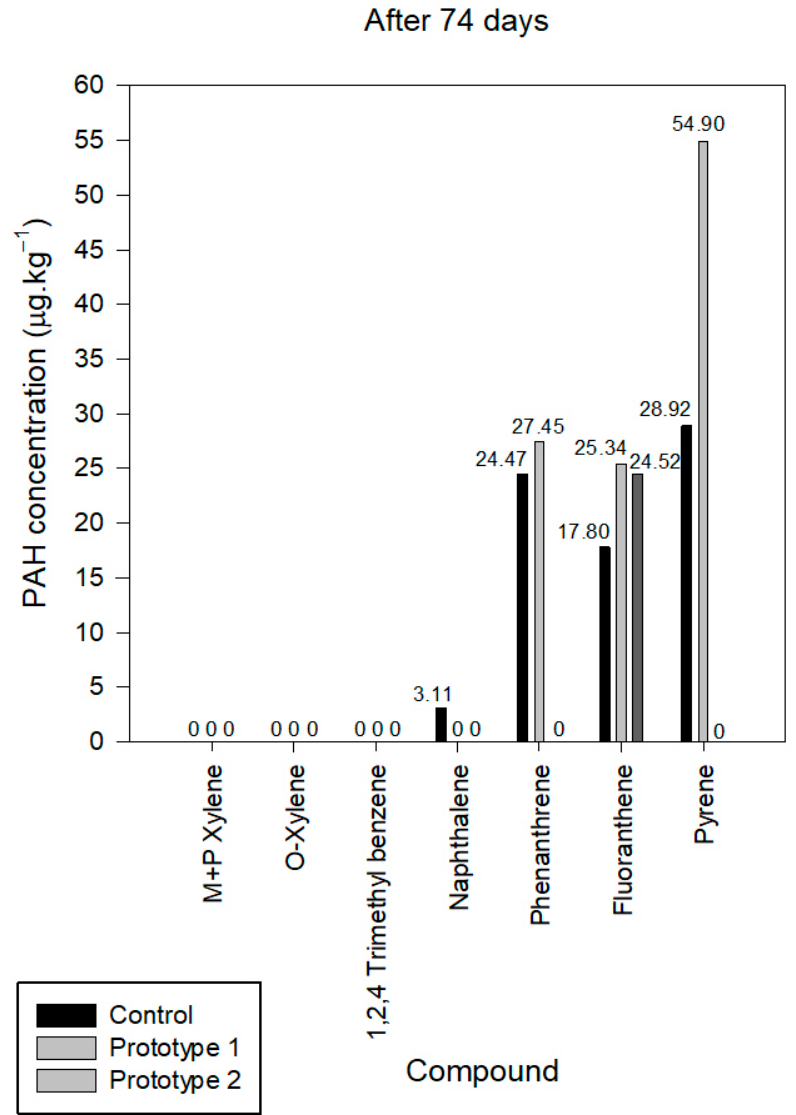
Figure 3. Polycyclic aromatic hydrocarbon (PAH) concentrations ( µ g · kg − 1 ) for the control and test systems after 74 days. n = 1.